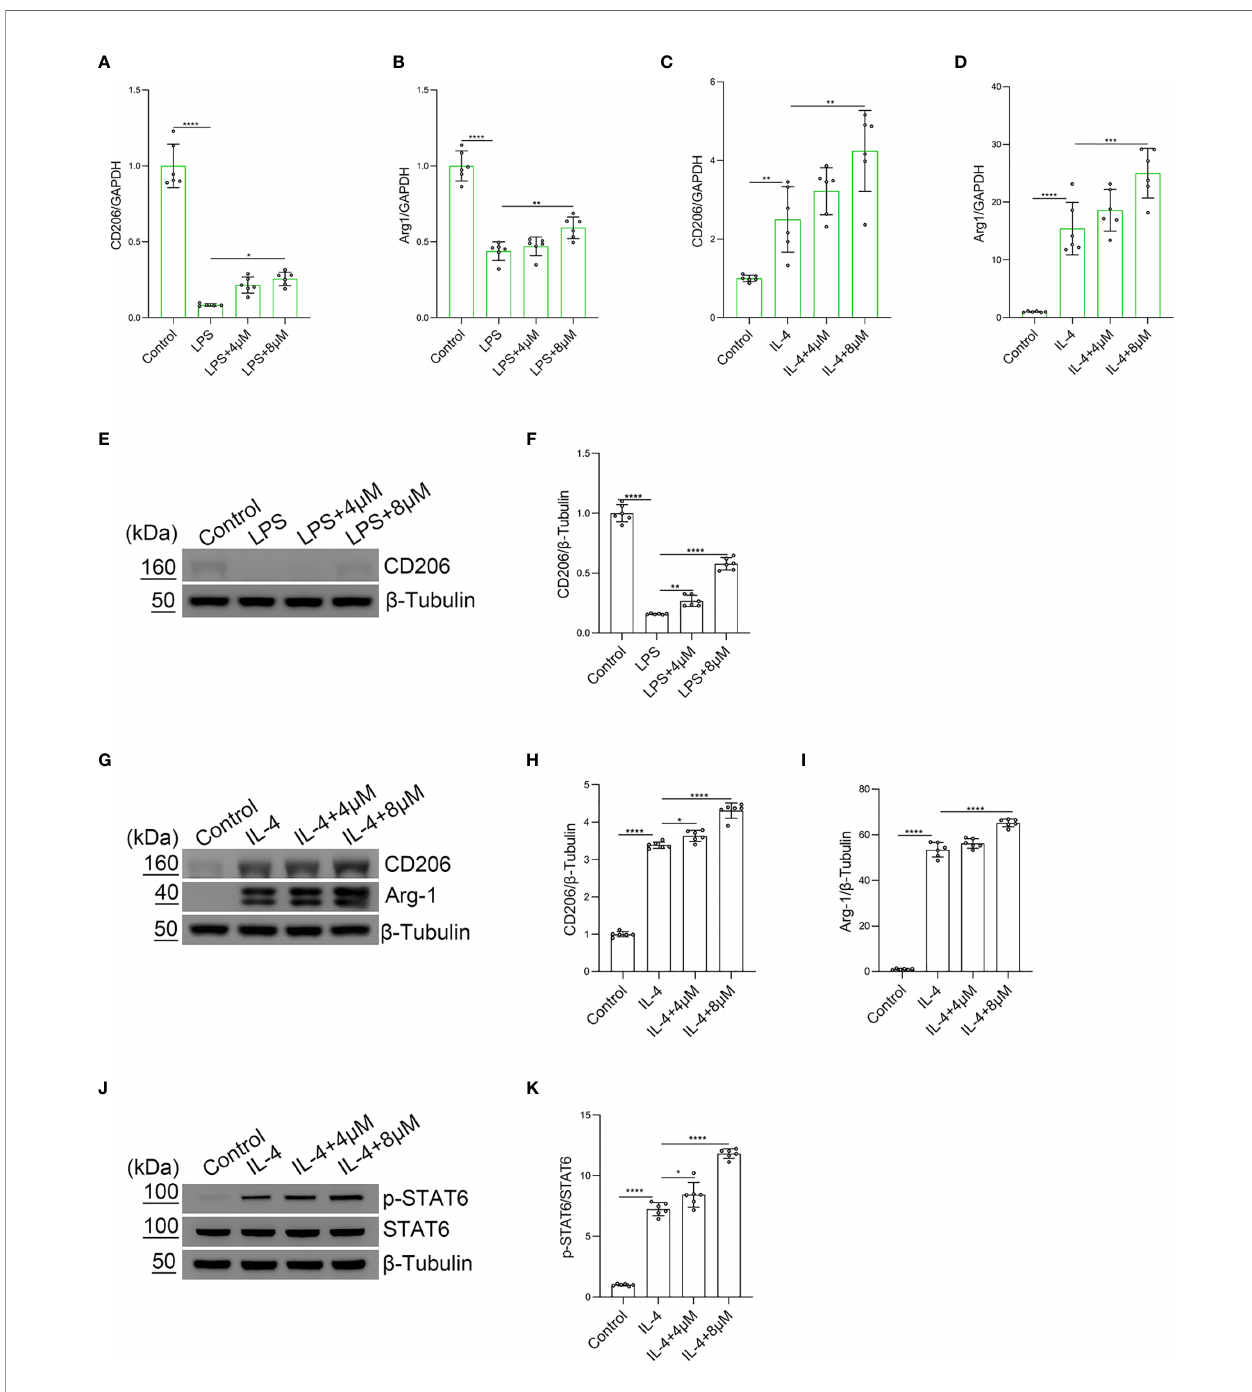
FIGURE 5 | Butorphanol promoted M2 macrophage polarization. Macrophages were collected and cultured from the bone marrow of mice and incubated with LPS (1 m g·mL -1 ) alone or butorphanol (4 m M or 8 m M) plus LPS (1 m g·mL -1 ) for 24 h. (A, B) The mRNA expression of M2 markers (CD206 and Arg-1) in cells was measured by qRT- PCR. (E) The protein levels of CD206 were measured by western blot analysis. (F) Densitometric analysis of CD206 expression in (E) was performed with normalization to b - tubulin. Macrophages were incubated with IL-4 (20 ng·mL -1 ) alone or butorphanol (4 m M or 8 m M) plus IL-4 (20 ng·mL -1 ) for 24 h. (C, D) The mRNA expression of M2 markers (CD206 and Arg-1) in cells was measured by qRT-PCR. (G) The protein levels of CD206 and Arg-1 were measured by western blot analysis. (H, I) Densitometric analysis of CD206 and Arg-1 levels in (G) was performed with normalization to b -tubulin. Macrophages were incubated with IL-4 (20 ng·mL -1 ) alone or butorphanol (4 m M or 8 m M) plus IL-4 (20 ng·mL -1 ) for 30 min. (J) The protein levels of phosphorylated STAT6 and total STAT6 were measured by western blot analysis. (K) Densitometric analysis of the phosphorylated STAT6 levels in (J) was performed with normalization to the respective total protein. The results are the means ± SEM of six independent experiments. Statistical analysis was performed by one-way ANOVA followed by Tukey ’ s post hoc test when comparing multiple independent groups. *P < 0.05, **P < 0.01, ***P < 0.001, ****P <